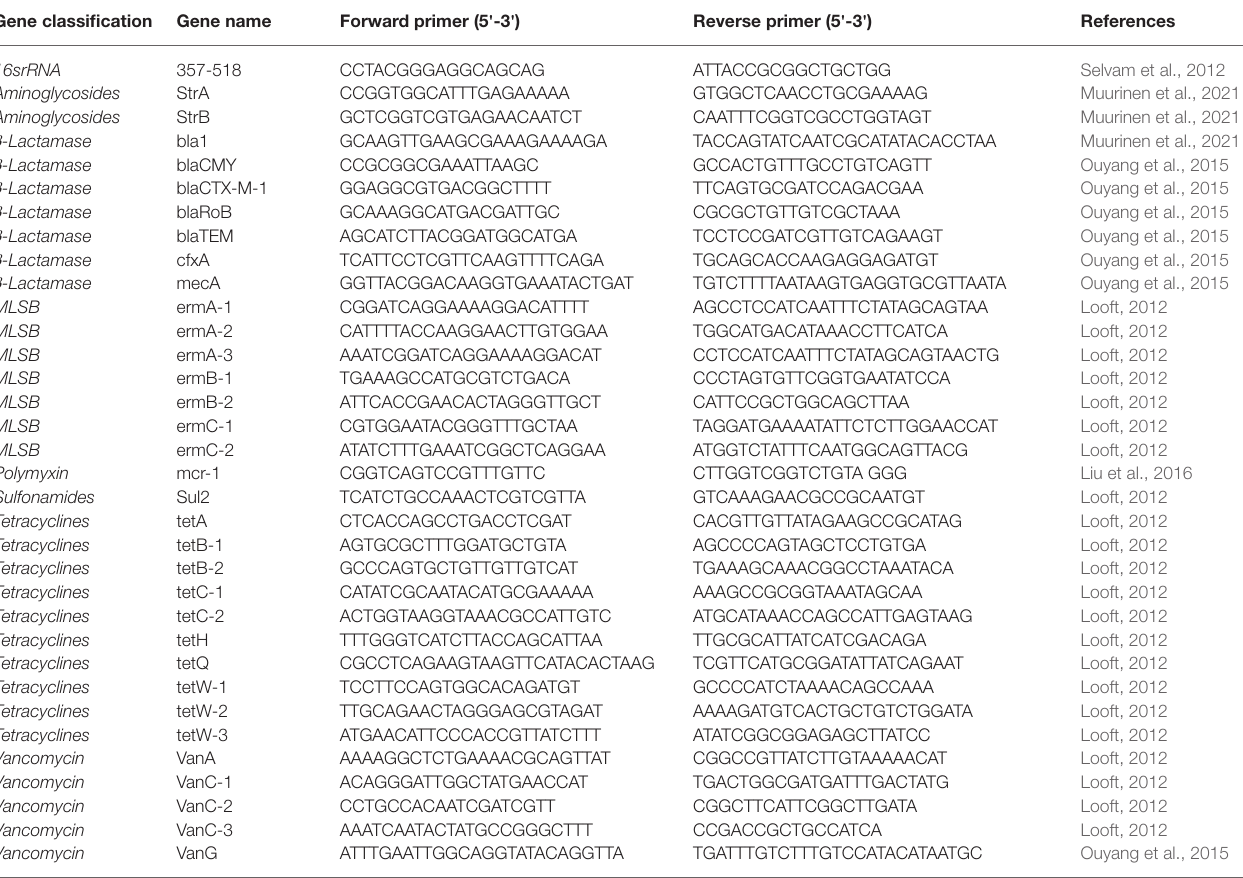
TABLE 1 | qPCR primers for antibiotic resistance genes (ARGs).